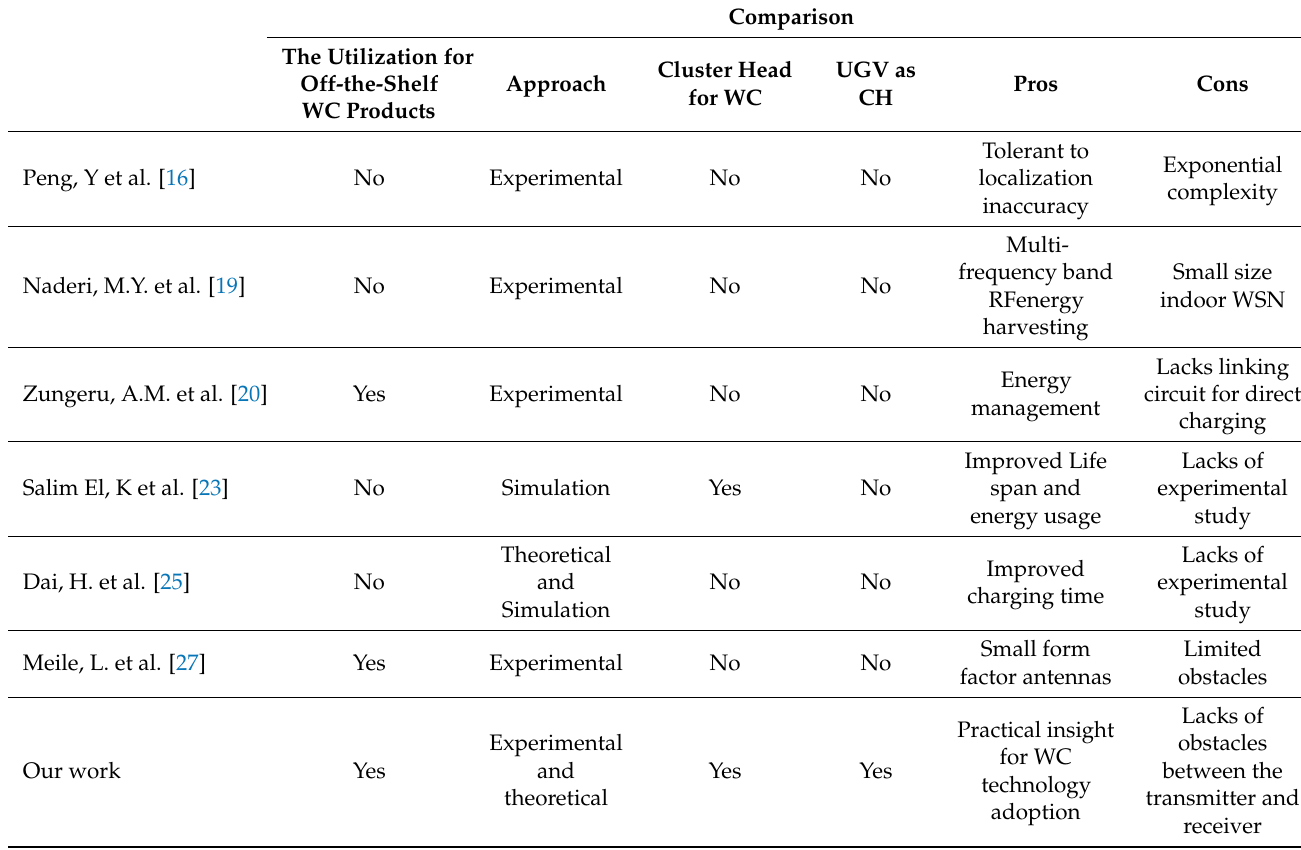
Table 1. Comparison of our work with other closely related works. Wireless Charging (WC); Unmanned Ground Vehicle (UGV); Wireless Sensor Networks (WSNs); and Cluster Head (CH). Comparison The Utilization for